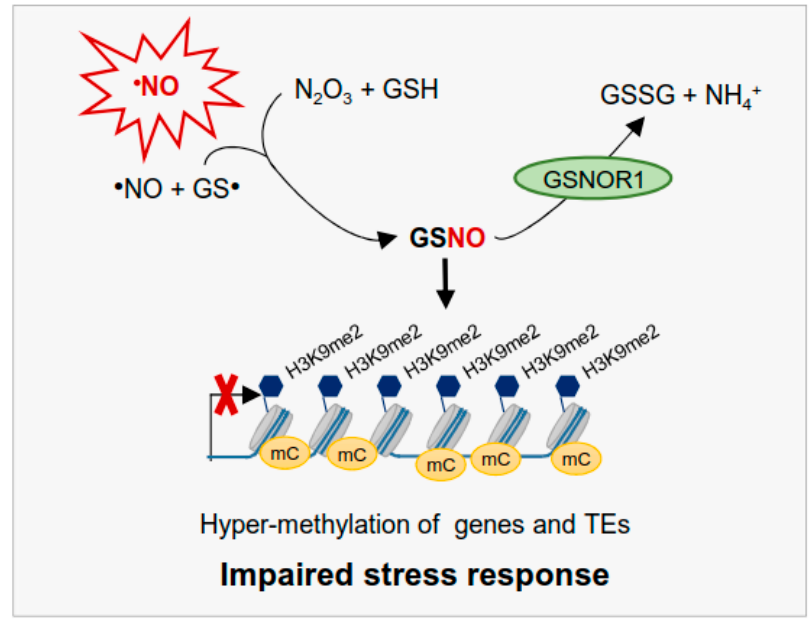
Figure 9. Proposed model illustrating the function of GSNOR1 in regulating methylation pro-